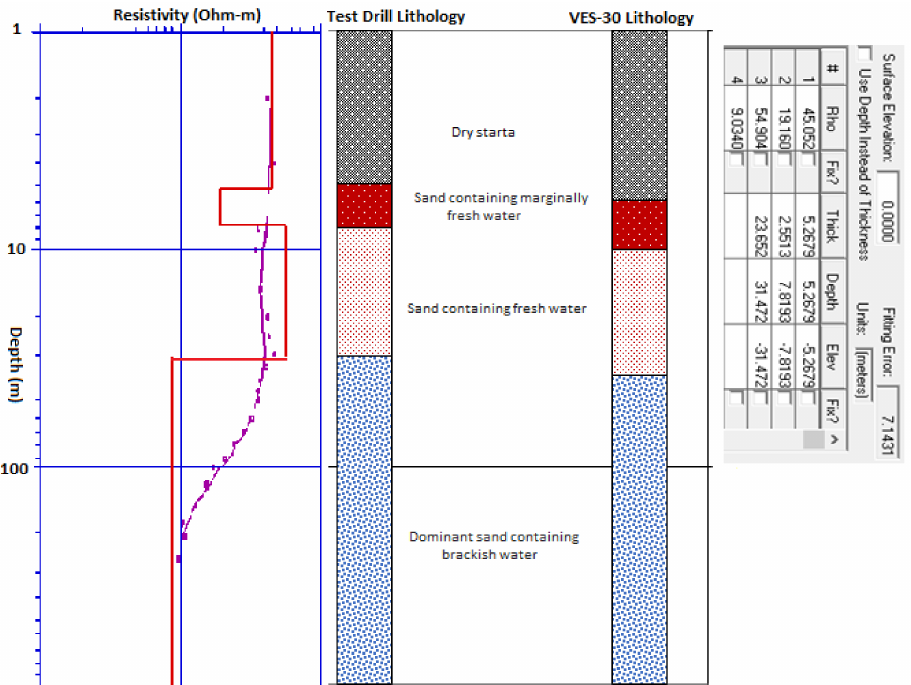
Figure 3. Correlation between sounding curve-30 with test drill lithology along with modeled parameters.